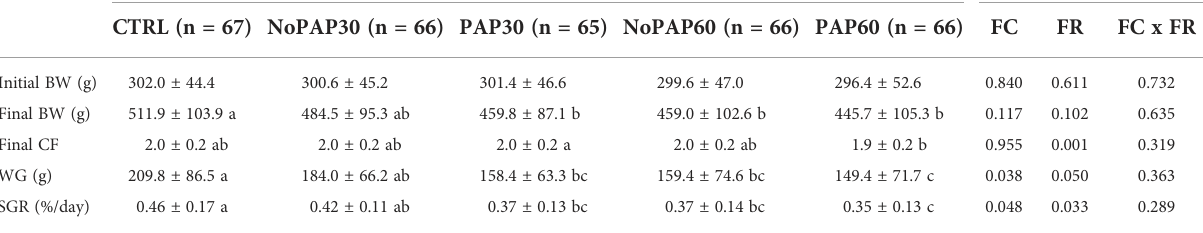
TABLE 4 Growth performance parameters of individually tagged turbot (N = 330) fed fi ve experimental diets. Experimental diets Two-Way ANOVA